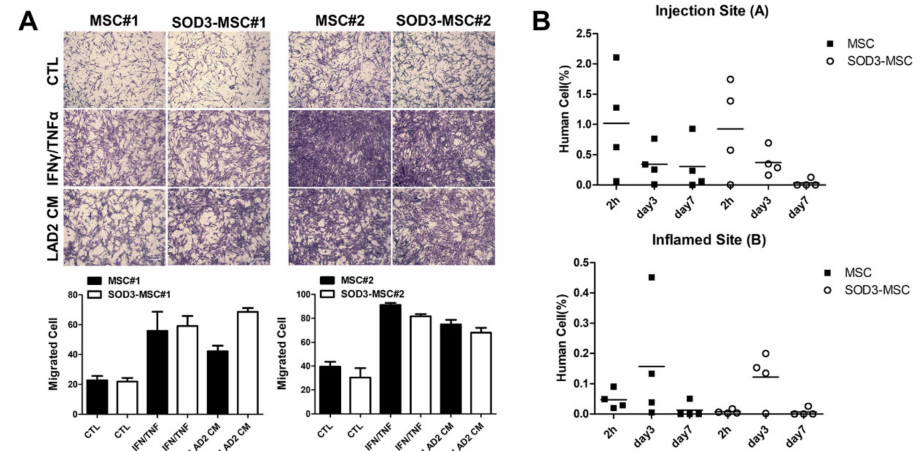
Figure 6. In vitro and in vivo migration of MSCs toward the inflammatory site. ( A ) Migration of MSCs and SOD3-MSCs in response to inflammatory factors was determined in vitro, using transwell. Representative photographs of migrated MSCs or SOD3-MSCs in the bottom of the upper chamber. Scale bar = 100 µ m. ( B ) The amount of MSCs in the injection site and inflamed site at 2, 72, and 168 h after injection, using qRT-PCR for human ALU sequence. Results are shown as mean ±